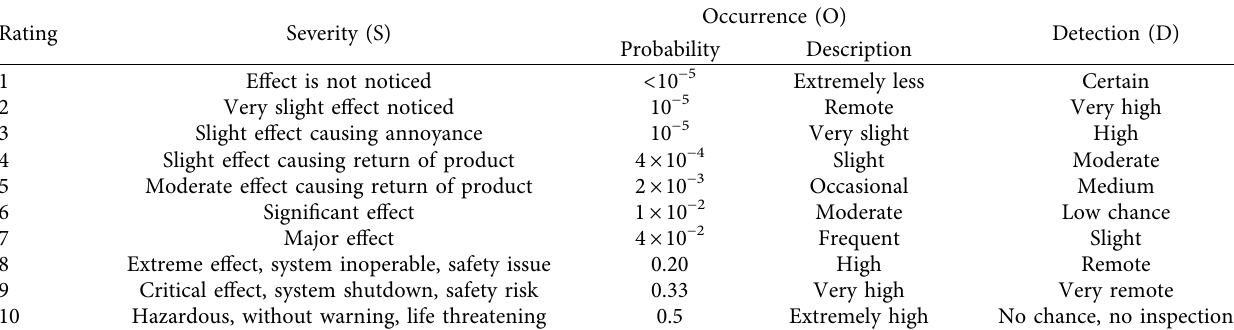
Table 1: Rating of severity, occurrence, and detection.